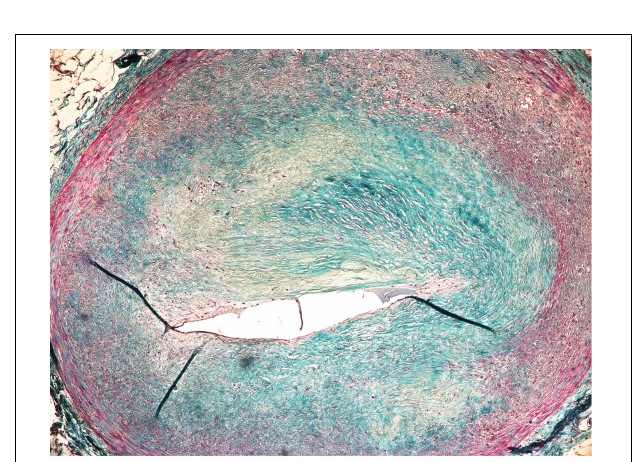
FIGURE 2 | Occluded, atherosclerotic left anterior descending artery with fibrous cap and a lipid core